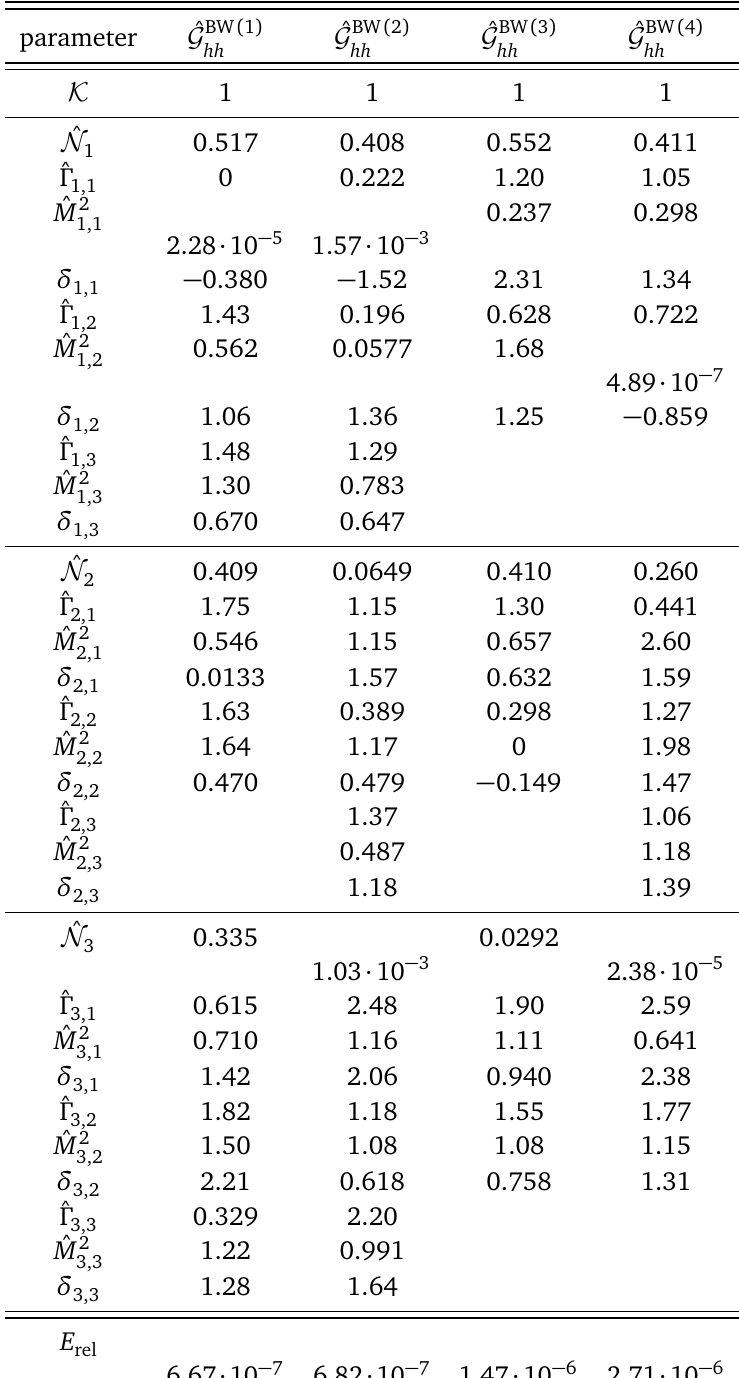
Table 1: Parameters for the reconstruction of the fluctuation graviton spectral function (central line in